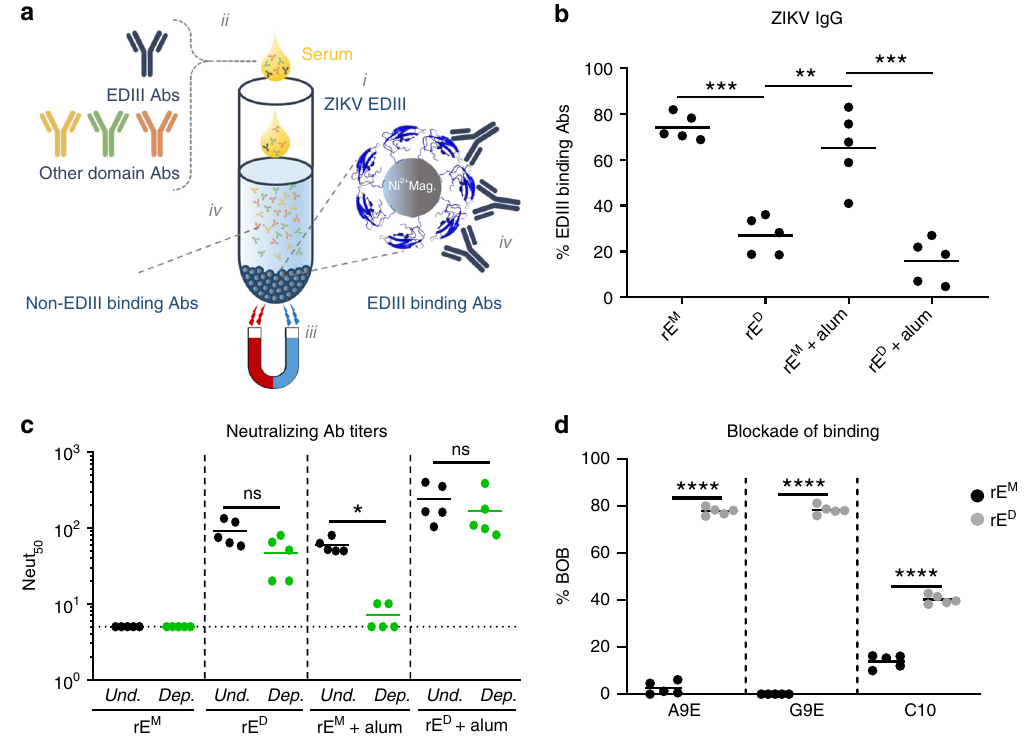
Fig. 3 ZIKV rE D stimulates antibodies that target complex epitopes on the virion. a Method for depleting EDIII-binding antibodies from mouse immune sera. Recombinant ZIKV E-domain III (EDIII, His-tagged) was coupled to nickel beads i then incubated with immune sera ii . Magnetic pull down removes nickel beads and EDIII-binding antibodies iii , leaving behind sera depleted from EDIII-binding antibodies iv . b The level of EDIII-binding antibodies in the serum of mice immunized with the indicated antigens is shown as a percentage of the total level of ZIKV-speci fi c IgG, as measured by ELISA of EDIII-depleted and control-depleted serum. c The neutralizing activity of EDIII-depleted (green) and undepleted sera (black) was determined and expressed as the dilution at which 50% of the virus was neutralized (Neut 50 ). d A blockade of binding (BOB) assay was used to evaluate if mice immunized with rE M (black) or rE D (gray) developed antibodies that blocked the binding of A9E, G9E, and EDE C10 human mAbs. Data points represent individual mice. Statistical differences were determined by one-way ANOVA followed by a Tukey ’ s test (* p < 0.05). Source data are provided as a Source Data fi